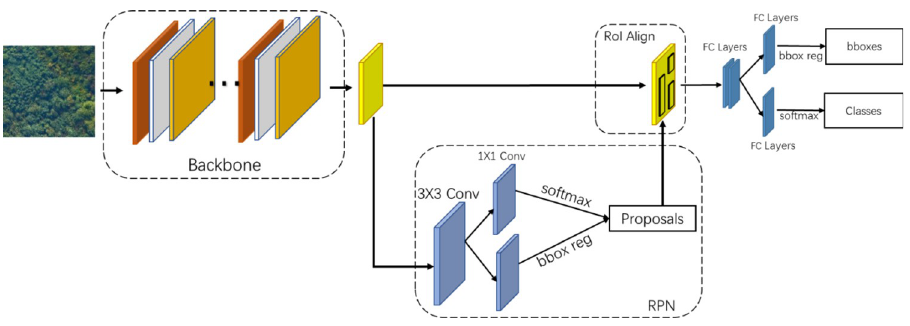
Fig 4. The architecture of faster-RCNN.